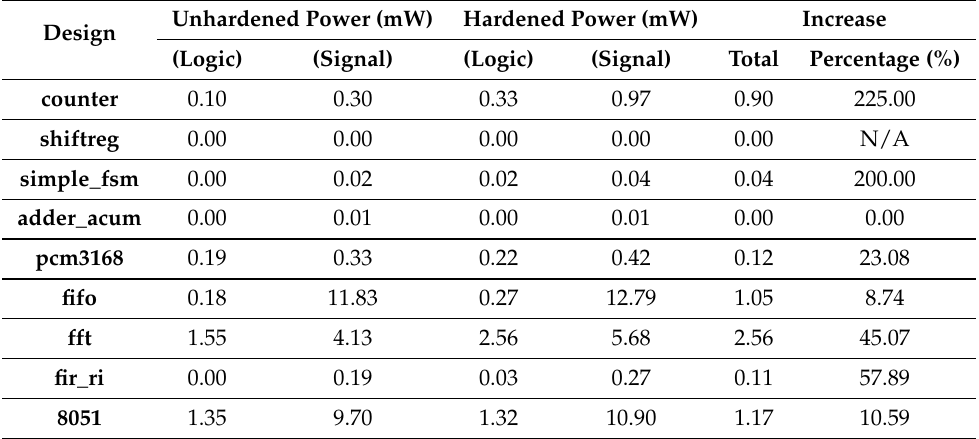
Table 9. Power consumption estimation of hardened and unhardened versions of the designs under test, synthesized with XST.